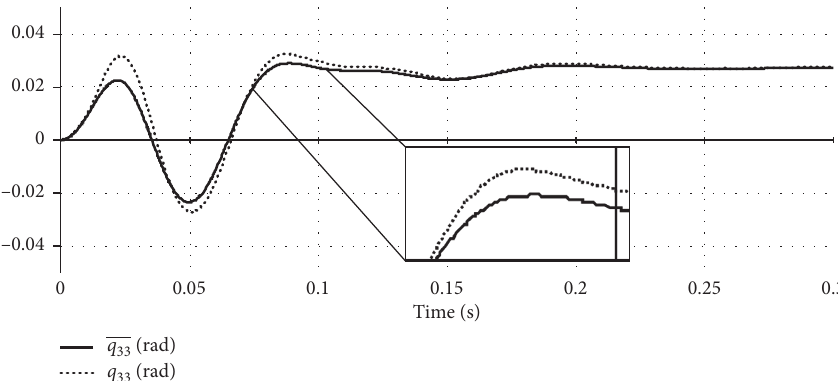
Figure 13: Performance of the slow variable q